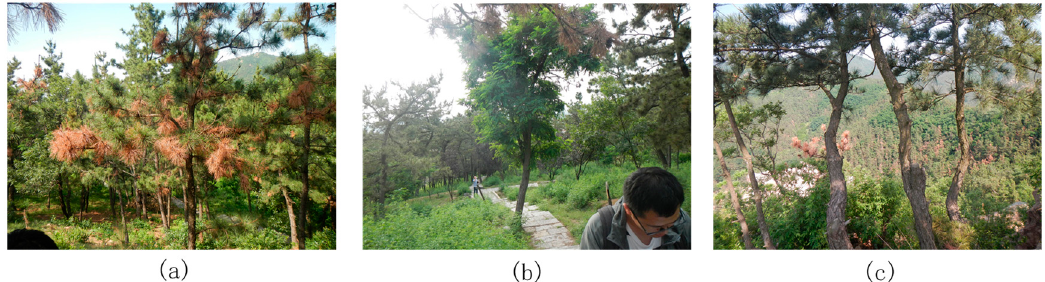
Figure 2. Field investigation in the south of Laoshan District. ( a ) Area 1; ( b ) Area 2; ( c ) Area 3.